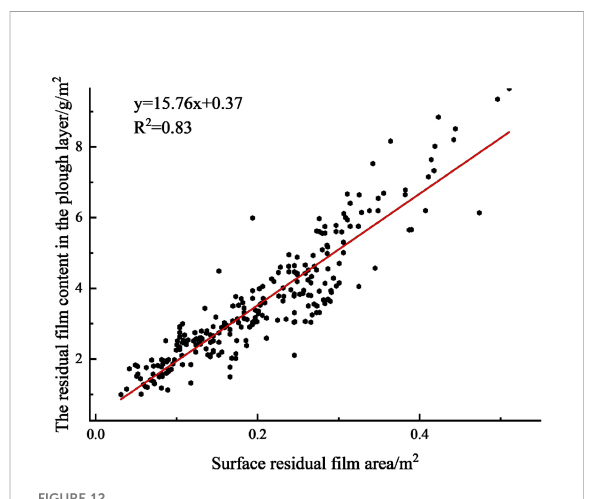
FIGURE 12 Prediction results for the residual fi lm content in the plough